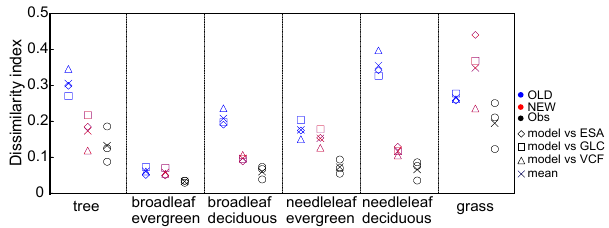
Figure 7. Dissimilarity index ( D , Eq. 11) for fractional cover of PFT groups including total tree, grass, and four tree subtypes be- tween model (OLD, blue, and NEW, red) and observations, and be- tween different observations (black), averaged over Northern Hemi- sphere (20–90 ◦ N). D ranges from 0 to1, with higher values repre- senting larger